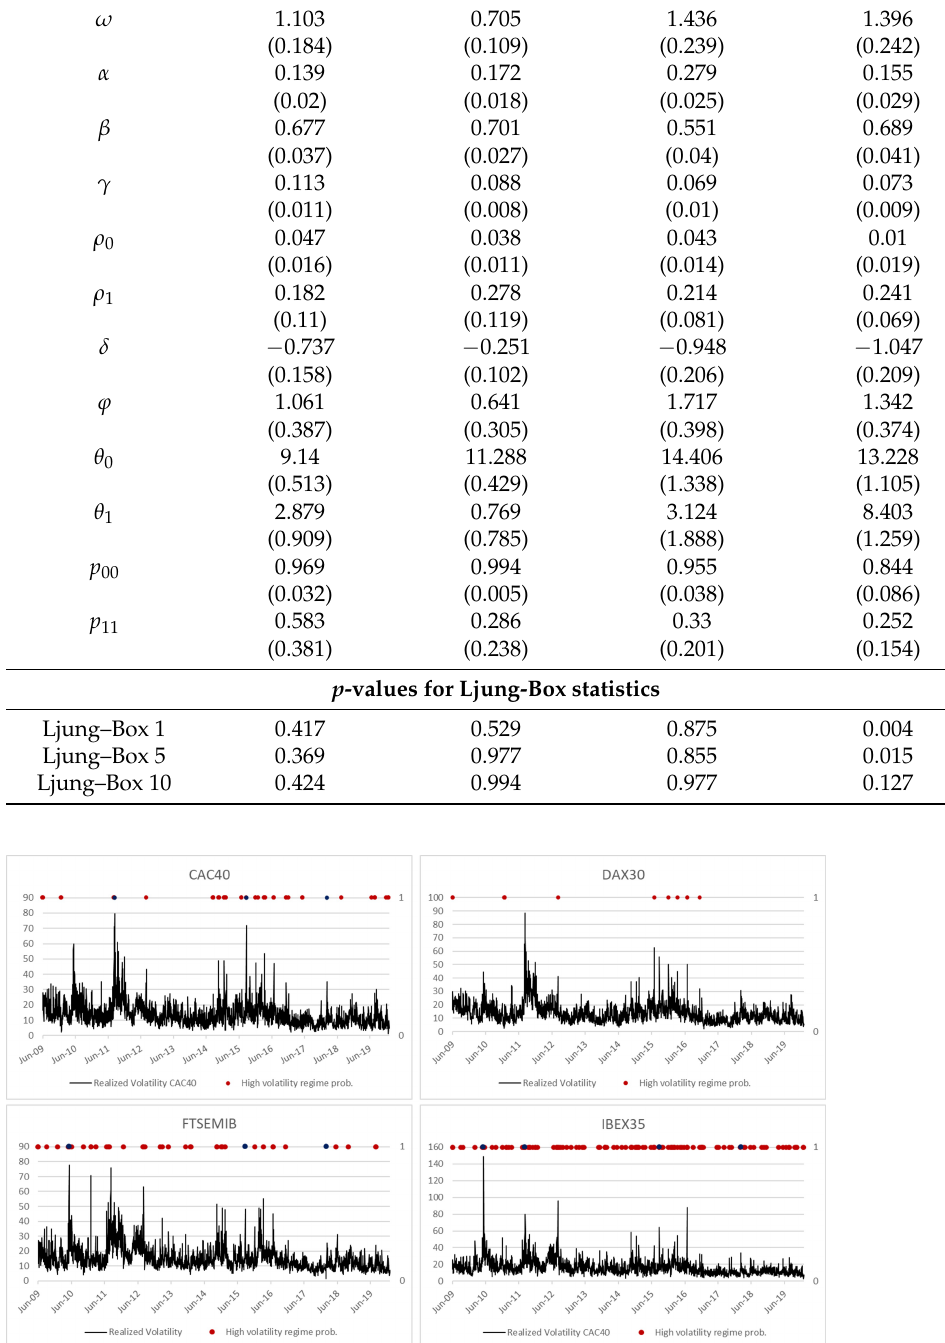
Figure 3. CAC40, DAX30, FTSEMIB and IBEX35 Realized Volatility (black line); red points represents the high volatility regime probability (in blue, high-volatility regime in correspondence with some important events, see text). Sample period: 1 June 2009 to 31 December